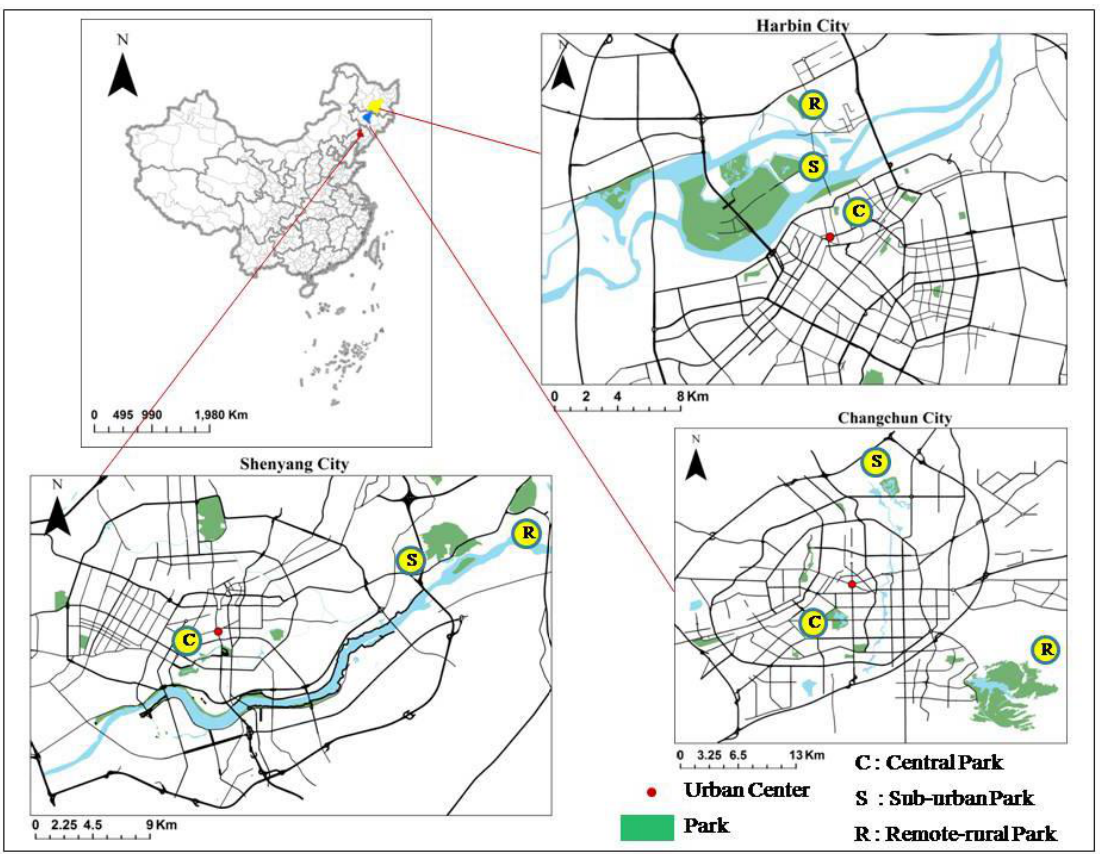
Figure 1. The distribution of urban forest parks locating at the city-center, suburban, and remote-rural areas of cities of Changchun, Harbin, and Shenyang in Northeast China.